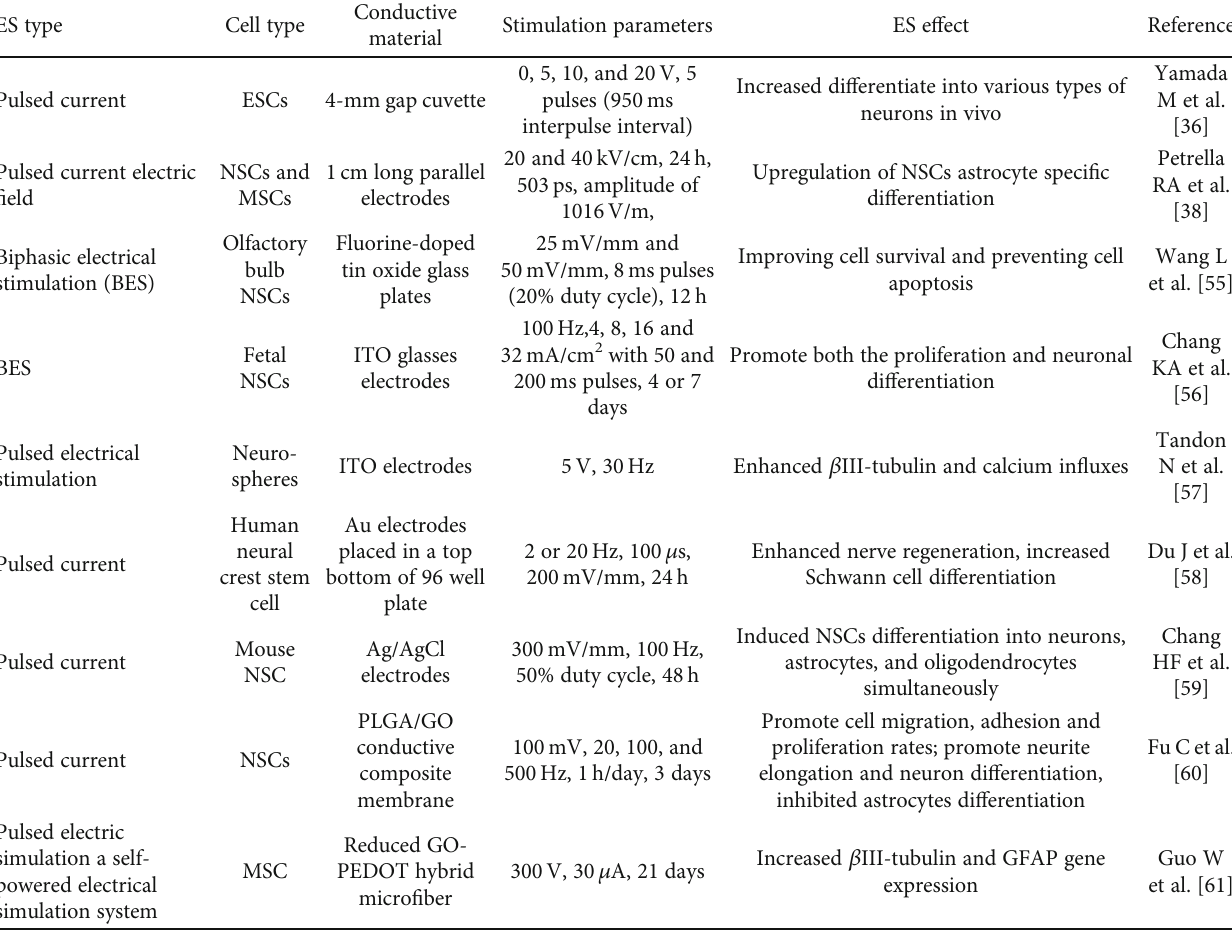
Table 4: Pulsed current stimulation used in stem cell neural di ff